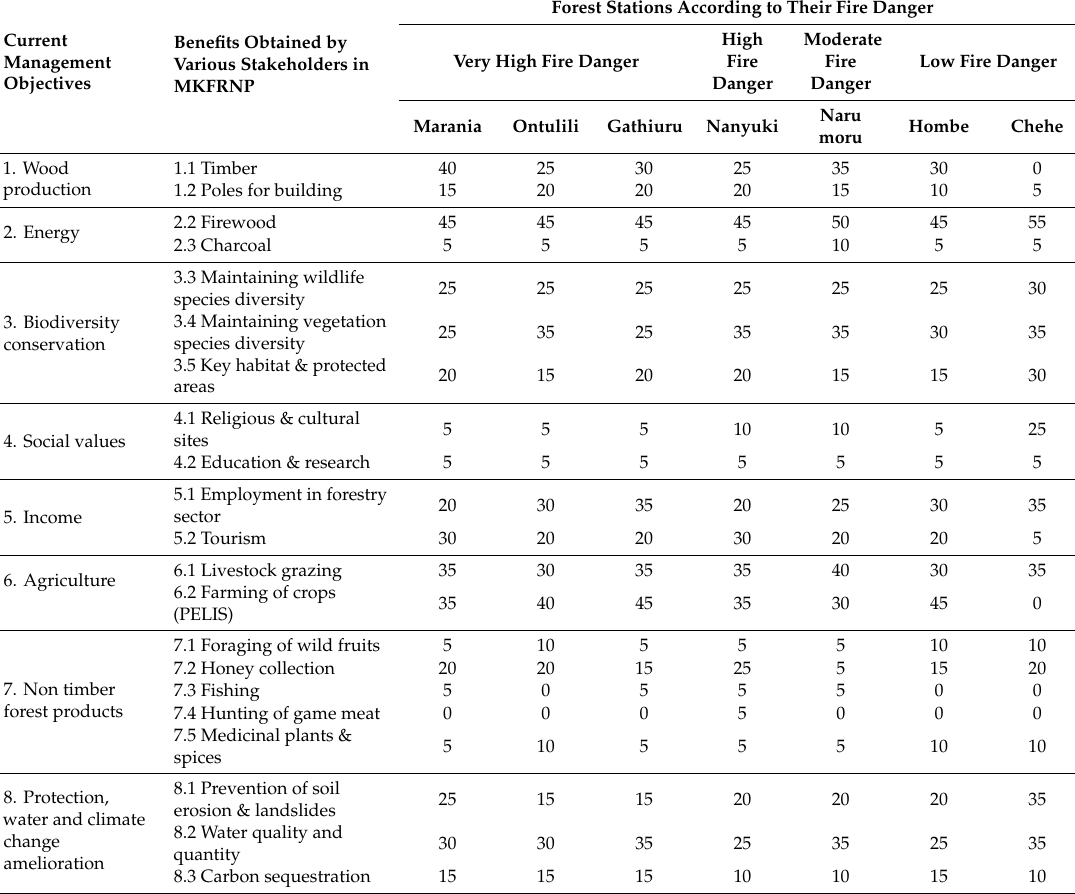
Table 3. Importance of the Objectives and Criteria in the seven forest stations based on the scores provided by the participants in the focus group discussions